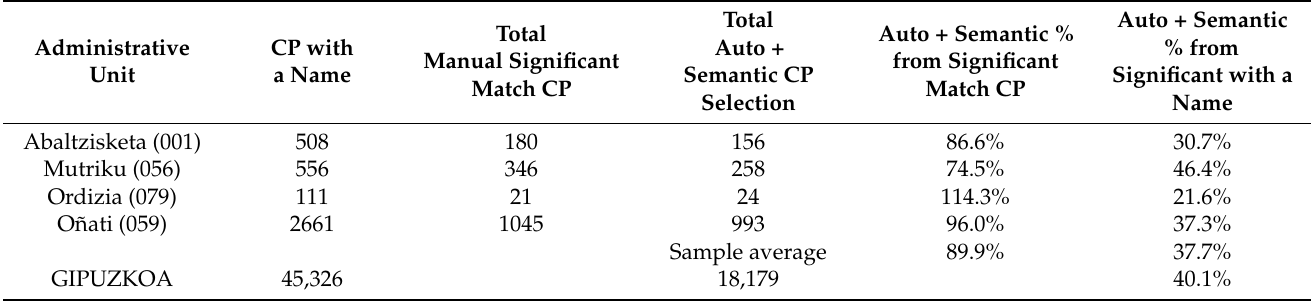
Table 6. Results obtained after the application of the automatic process in the total population (on the parcels of the entire